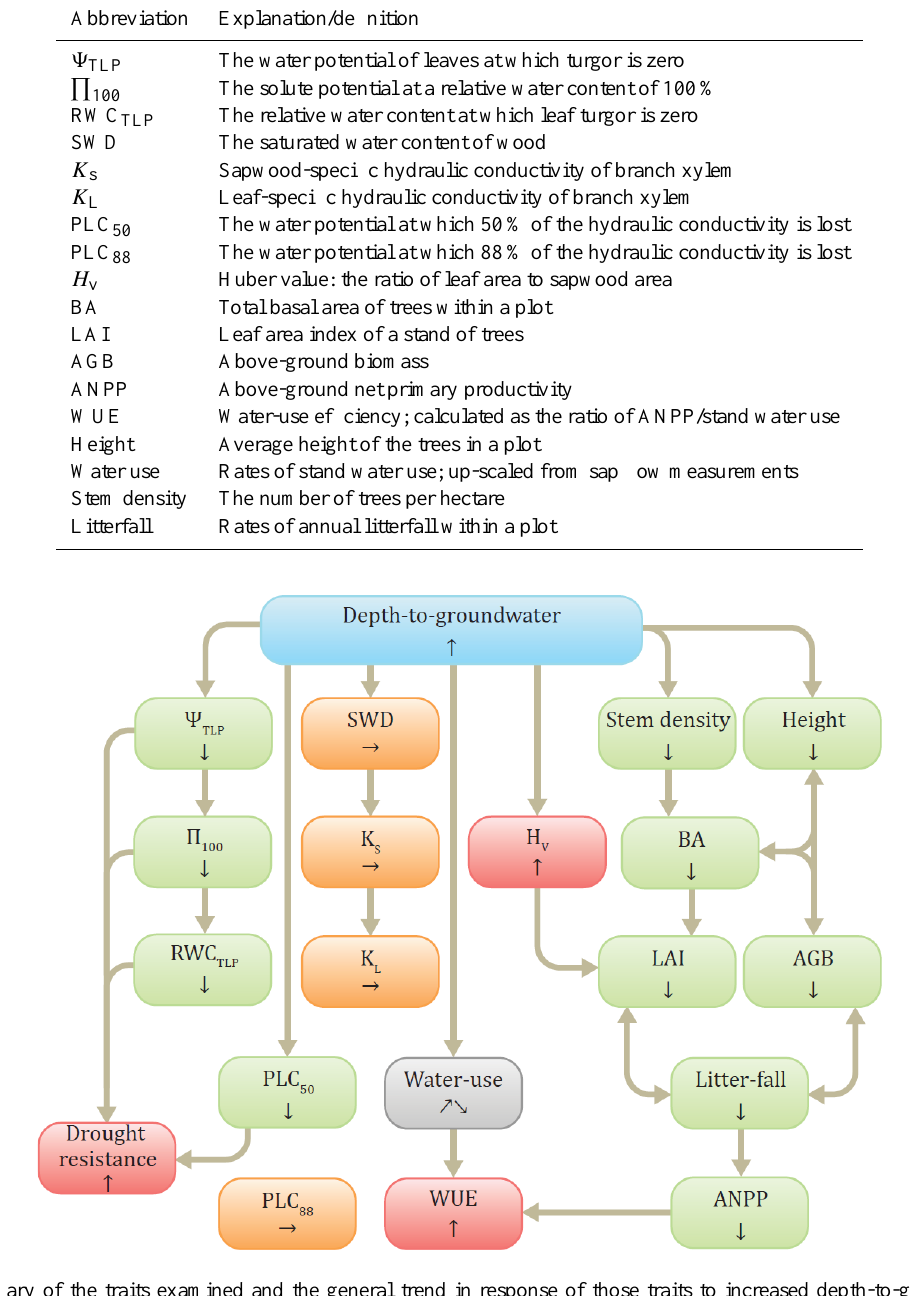
Figure 7. A summary of the traits examined and the general trend in response of those traits to increased depth-to-groundwater along a natural topographic gradient. Upward/downward pointing arrows within a coloured text box indicate increasing/decreasing values of the plant trait as depth-to-groundwater increases. Horizontal arrows indicate no change. Table 4 provides the definition of all abbreviations used in this